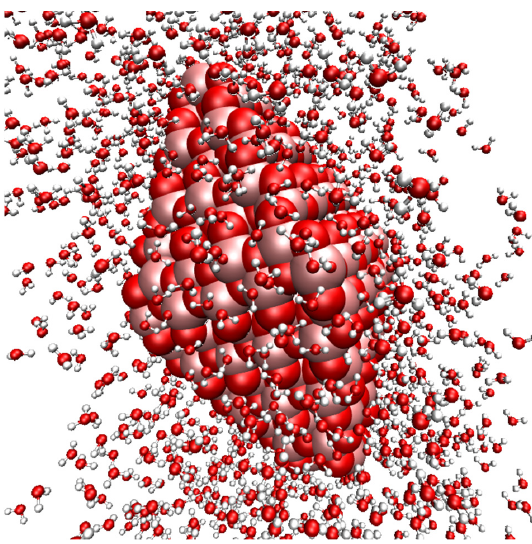
Figure 1. The anatase nanoparticle surrounded by water molecules. Oxygen atoms are red, titanium is pink and hydrogen is white.